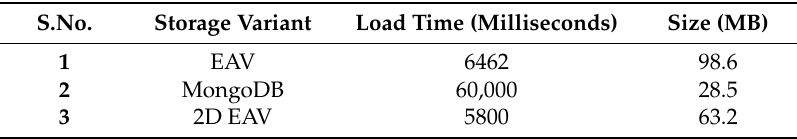
Table 2. Load time and storage acquired by various storage